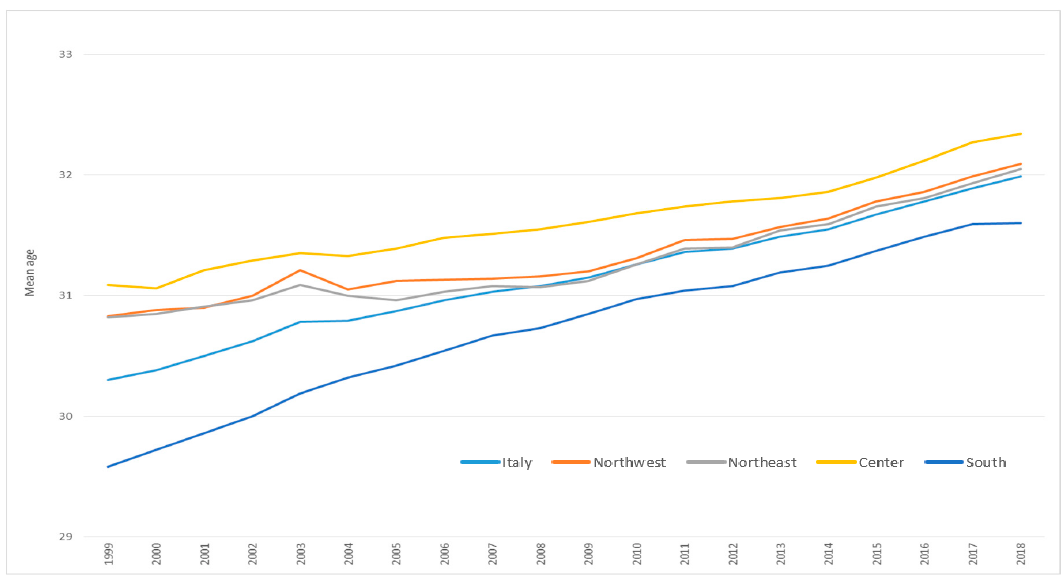
Figure 8. Mothers’ mean age at childbirth in Italy overall and by area of residence. Italy, 1999–2018. Source: Population Register of the Italian National Institute of Statistics (Istat).